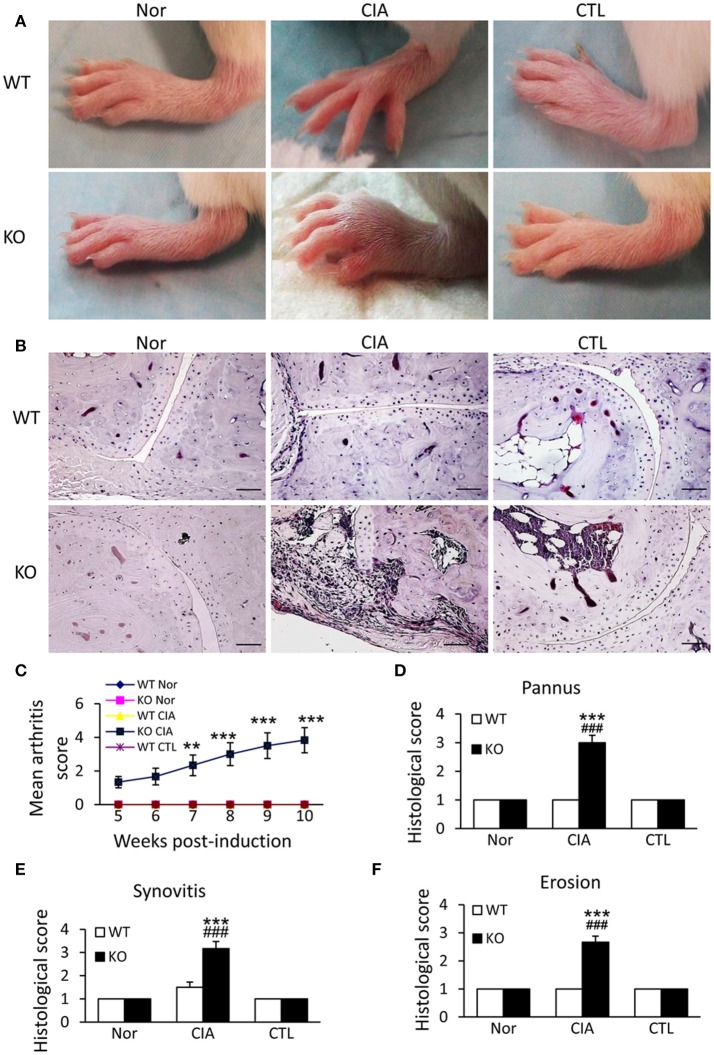
Smad7 deficiency promotes the susceptibility to CIA in CD-1 mice. (A) Severe swelling of paws is developed in Smad7-KO but not in Smad7-WT CIA mice at week 10 after disease induction. (B) Severe pathological changes with massive inflammatory responses are developed in Smad7-KO but not in Smad7-WT CIA mice at week 10 after disease induction. Scale bar, 50 μm. (C–F) Pathological mean scores of arthritis (C) pannus (D) synovitis (E) and erosion (F) at week 10 of paws tissues. Data are expressed as mean ± S.E. for group of 8 mice. **p < 0.01, ***p < 0.001 vs. control (CTL); ###p < 0.001 vs. CIA-Smad7-WT mice.